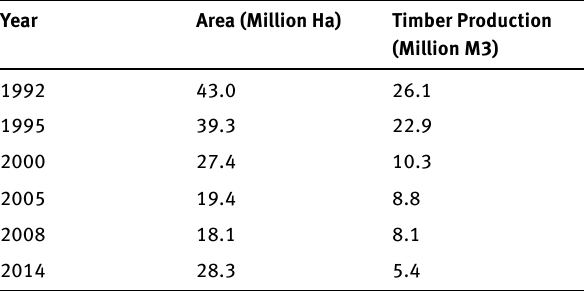
Table 5: Forest Concession Area and Timber Production in Conces-